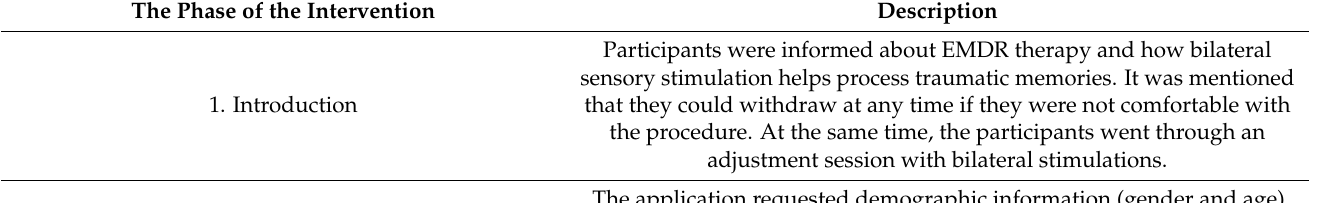
Table 3. Application protocol